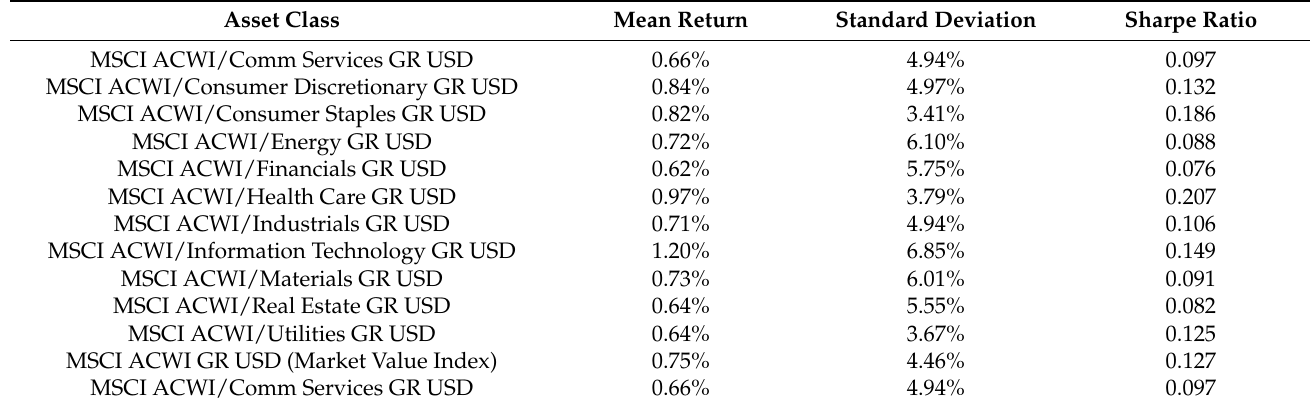
Table 1. Descriptive statistics of the